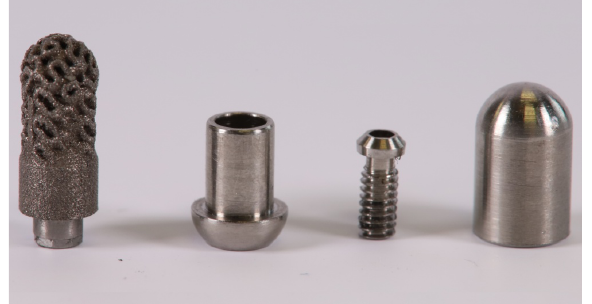
Figure 4. A disassembled specimen of the EH vari- ant used for the mechanical tests. Although the body of the implant is di ff erent, the locking system includ- ing the abutment and screw are the same.